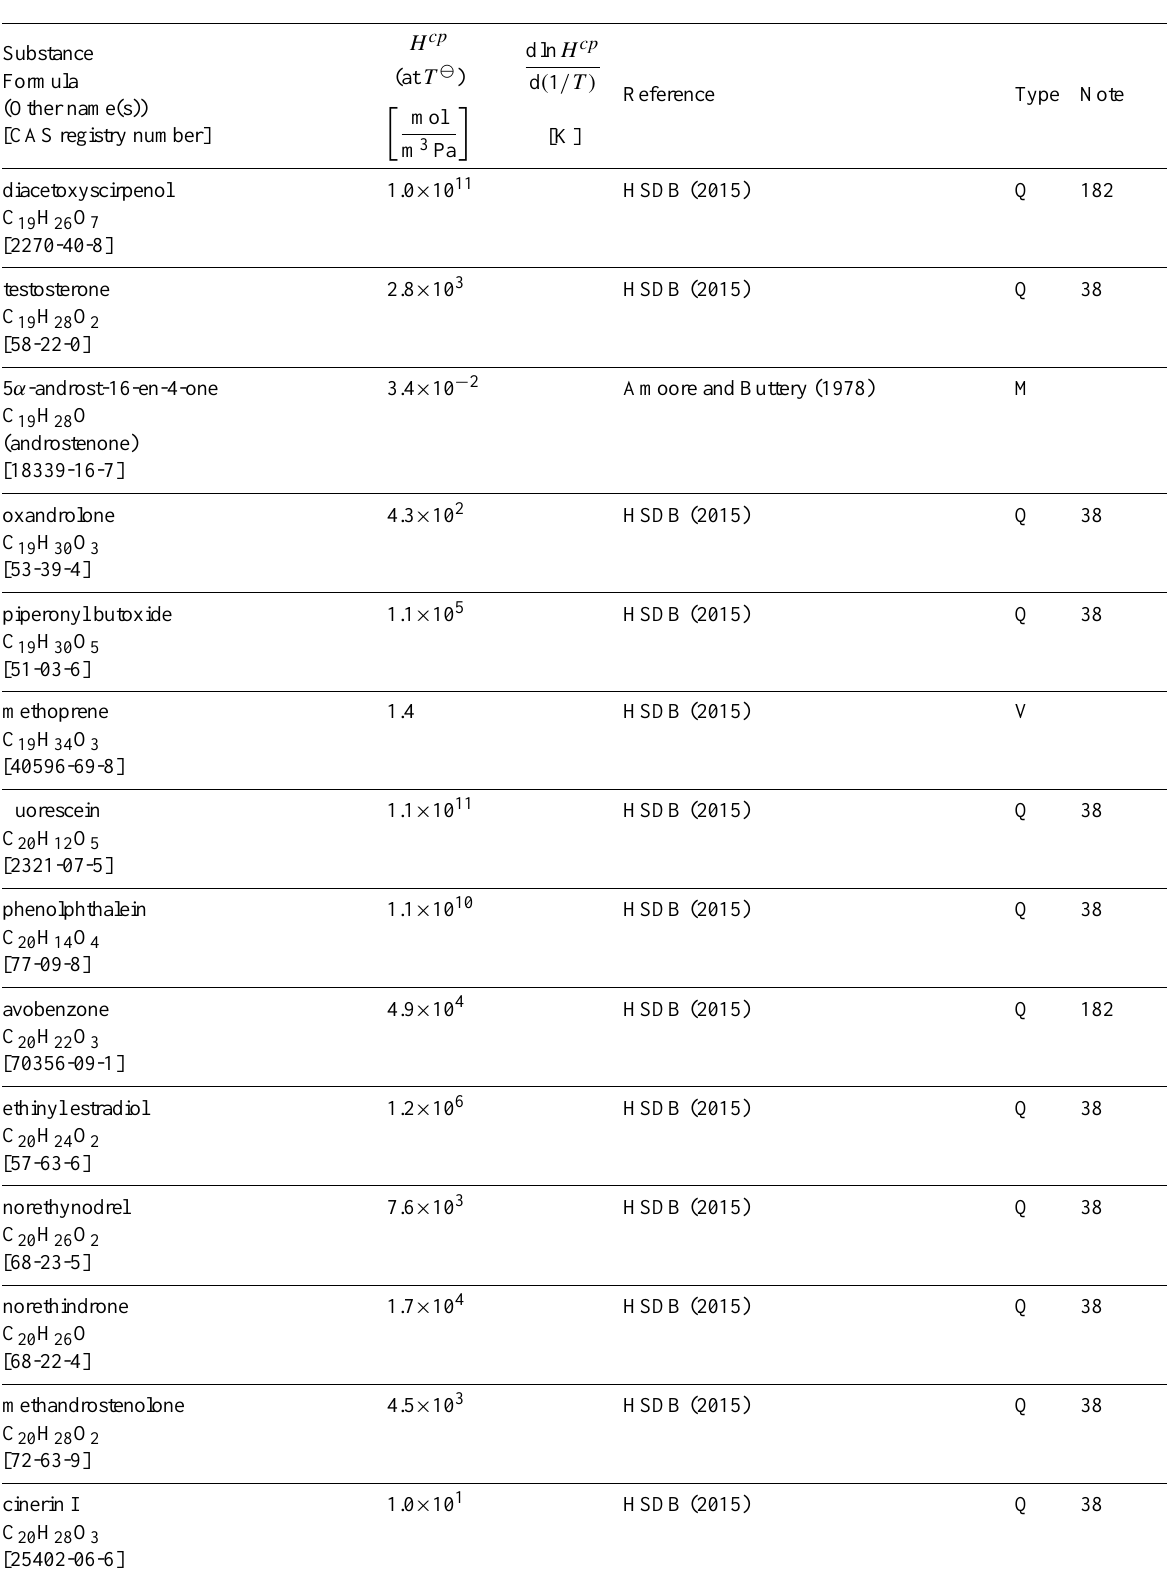
Table 6: Henry’s law constants for water as solvent